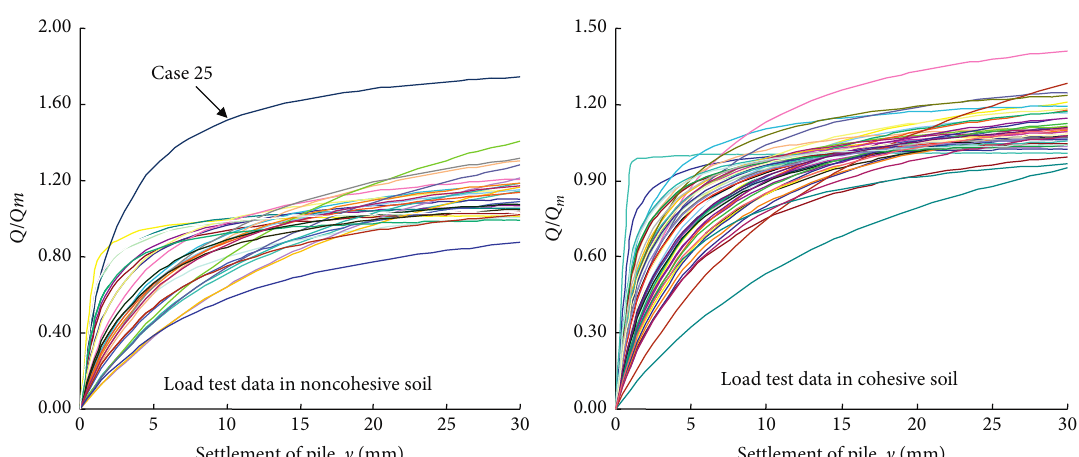
Figure 1: Normalized load-settlement curves of load test data.